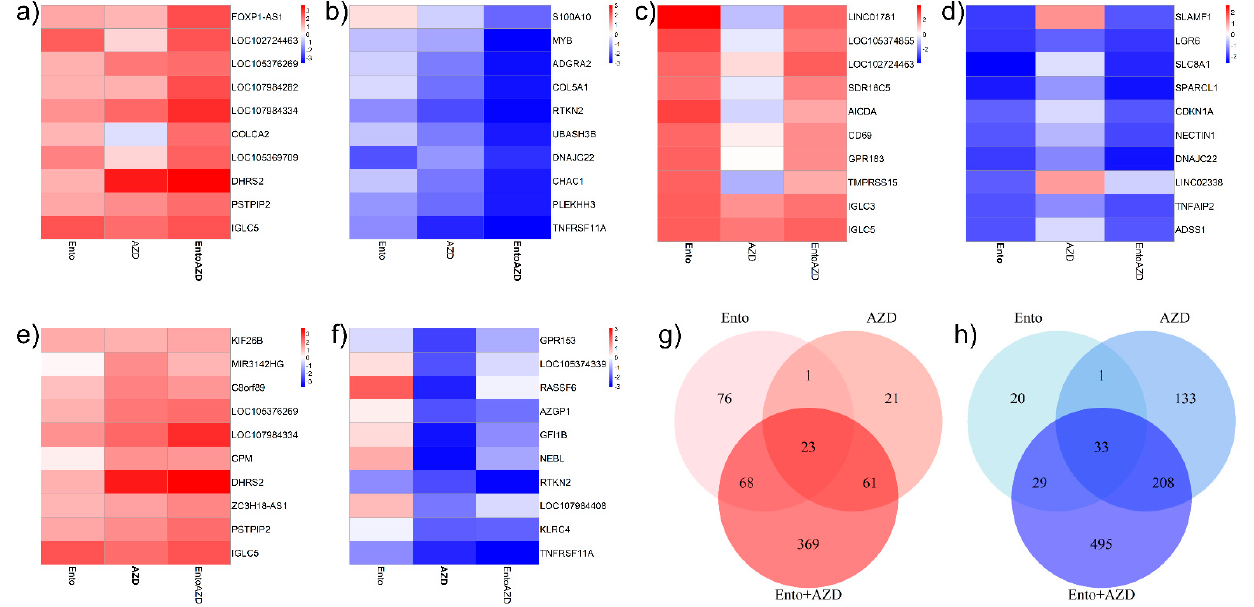
Figure 6. Top 10 over- and underexpressed DEGs and gene intersections in SU-DHL-4 by RNAseq. Heatmaps indicating differential expression of the top 10 DEGs by the respective condition. ( a ) Top 10 overexpressed genes induced by Ento+AZD combined exposure compared to the both single agents in SU-DHL-4 and ( b ) Top 10 underexpressed genes, respectively. ( c ) Top 10 overexpressed genes induced by Ento single agent compared to AZD single agent and Ento+AZD combination and ( d ) Top 10 underexpressed genes, respectively. ( e ) Top 10 overexpressed genes induced by AZD single agent compared to Ento single agent and Ento+AZD combination and ( f ) Top 10 underexpressed genes, respectively. Color range indicates respective | logFC| values. Bold print condition indicates the condition which is analyzed. Treatment conditions in SU-DHL-4 revealed gene intersections and uniquely deregulated genes. ( g ) Gene intersections of overexpressed genes between the treatment conditions (Ento single agent, AZD single agent, Ento+AZD combination) in SU-DHL-4 cells ( h ) Gene intersections of underexpressed genes between the treatment conditions (Ento single agent, AZD single agent, Ento+AZD combination) in SU-DHL-4 cells.